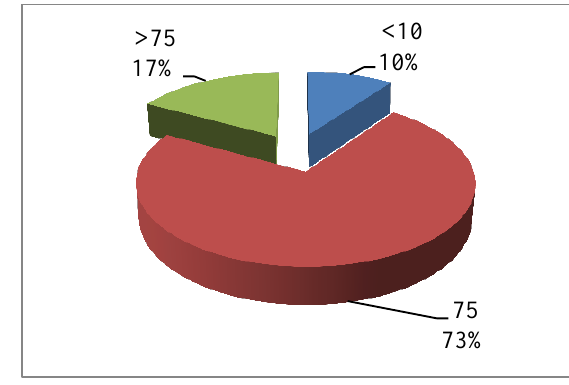
Fig. 5. Characterization of proteins by molecular weight of C. albicans obtained with frosting-defrosting